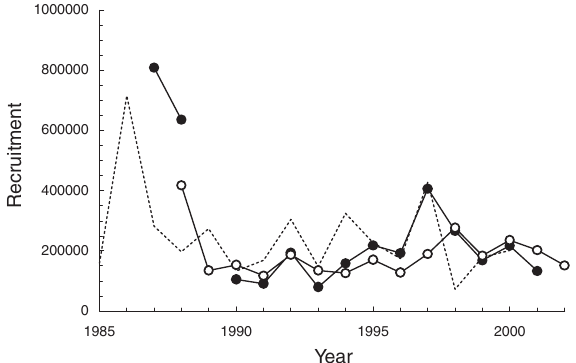
F IG . 4. – Comparison of the time series of recruitment of North Sea cod taken from the most recent VPA (dotted line), recruitment ‘nowcasting’ based on the Ricker SSB-SST model using SST observations (plain line, closed circles) and recruitment ‘forecast- ing’ using zero month lead SST forecasts (plain, open circles). Nowcasts and forecasts are produced respectively in October and January of the year preceding recruitment at age 1. For each year, the model was fitted and recruitment predictions generated using only the information available to the assessment working group at that